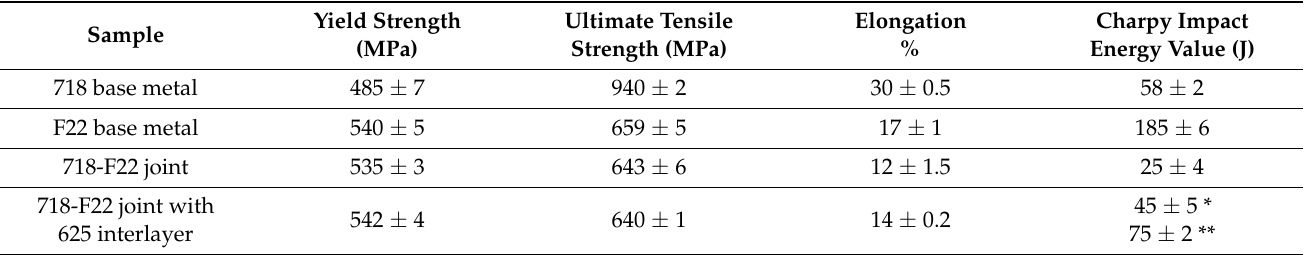
Table 3. Results of tensile testing of base metals and 718-F22 friction weld joints with and without 625 interlayer (average properties from three tests in each